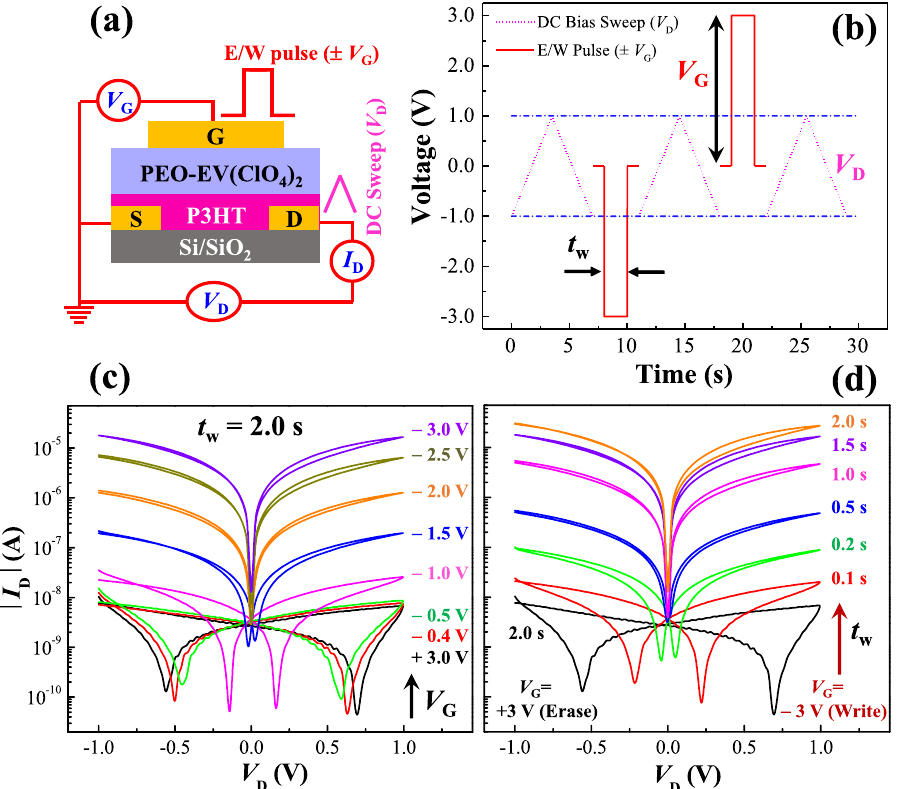
Figure 1. ( a ) Schematic diagram of the redox-electrolyte gated thin-film memtransistor ( mem T) including the details of the pulse and sweep measurement protocol. ( b ) Schematic representation of the voltage pulses at the gate terminal and DC voltage sweep across source-drain (S-D) contacts to measure the channel conductivity of the fabricated 3-terminal mem T devices. ( c, d ) Show multiple discrete conducting states of the device channel measured after applying different voltage pulse amplitudes ( V GS ) and widths ( t w ),